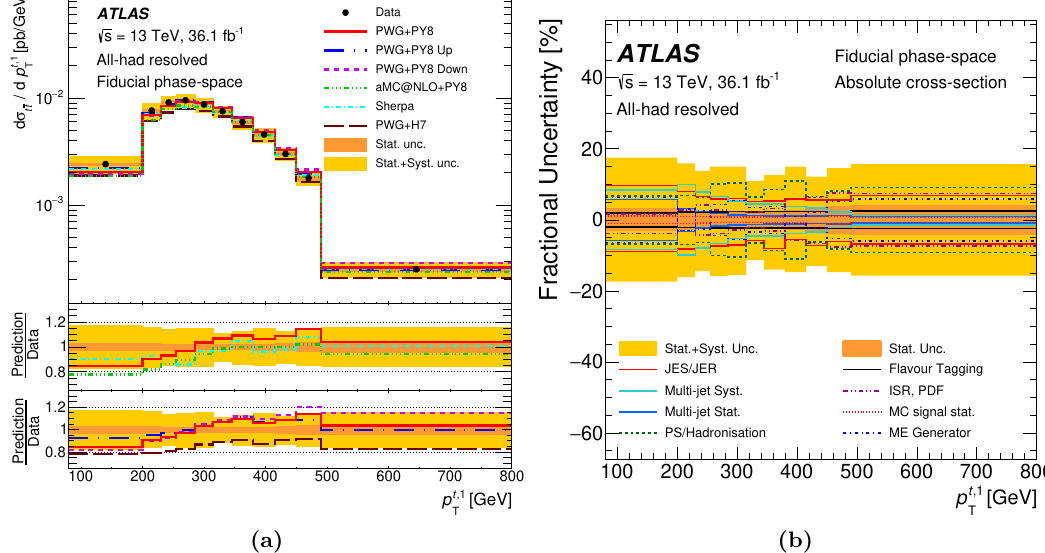
Figure 7 . Particle-level single-differential absolute cross-section measurement (a), as a function of the leading top-quark transverse momentum. The unfolded data are compared with theoretical predictions. In the top panel, the unfolded data are shown as black points, while lines indicate the predictions from several MC programs. Uncertainties are shown by the shaded bands. Data points are placed at the centre of each bin. The lower two panels show the ratio of the MC predictions to the unfolded data. Fractional uncertainties (b) for the absolute single-differential cross-sections as a function of the leading top-quark transverse momentum. The bands represent the uncertainties in the unfolded data. Lines indicate the breakdown of the major components of the